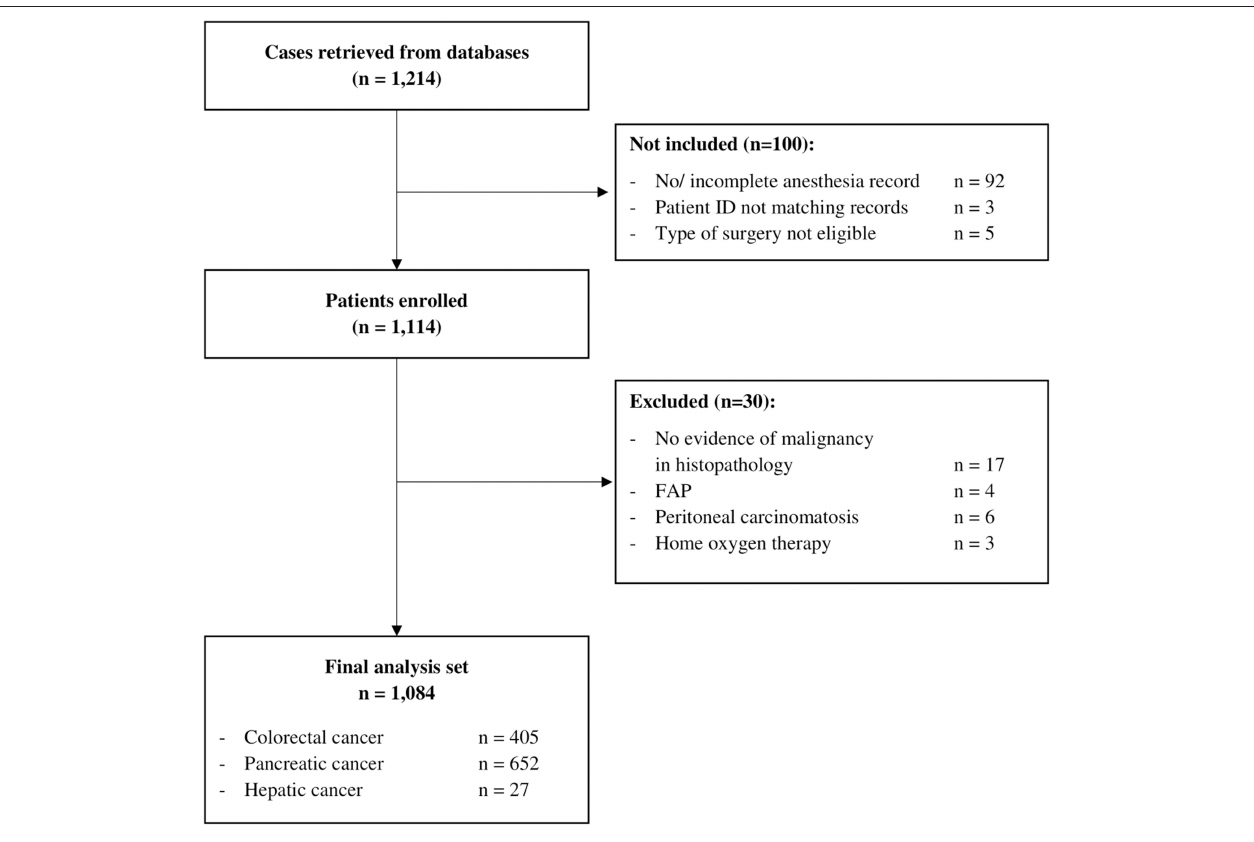
FIGURE 1 | Participant flow